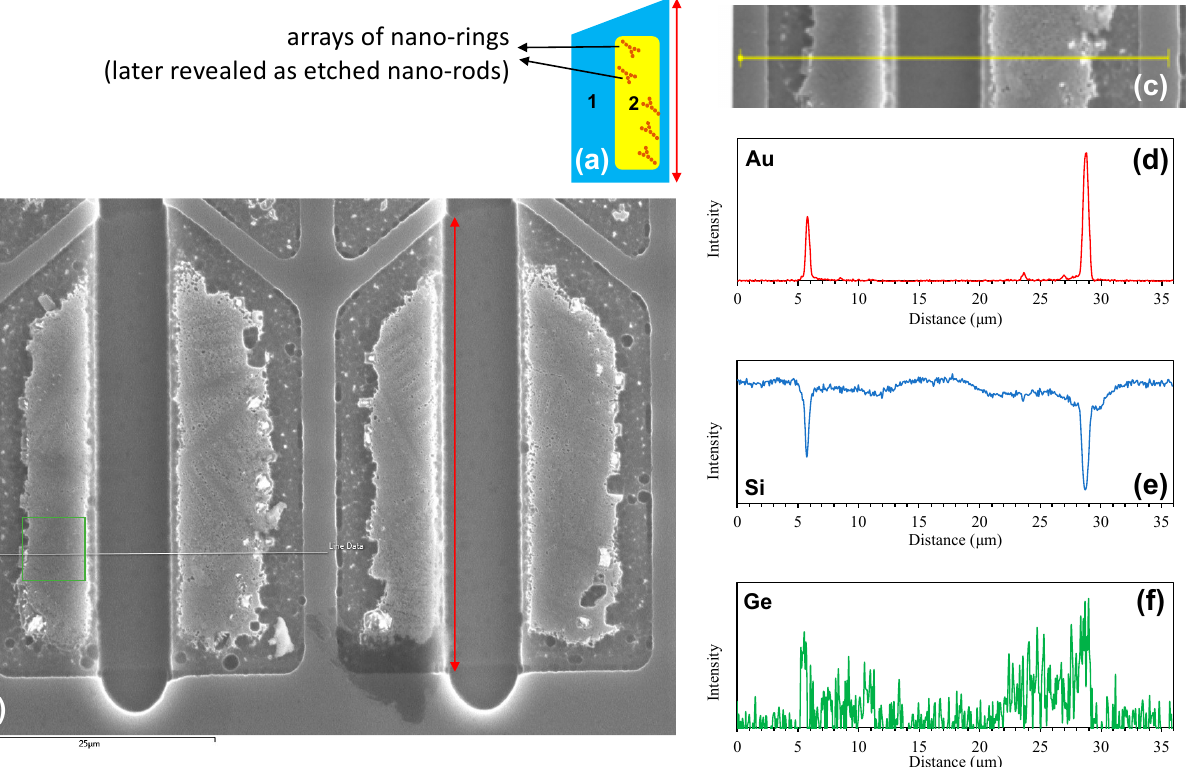
Figure 5. ( a ) Plan-view schematic of the sample with a large opening (shown by a red double arrow) with two regions: (1) dark outer and (2) bright inner regions that have arrays of nano-rings (later revealed as etched nano-rods). ( b ) Plan-view SEM micrograph of micro-crucibles with a large opening showing the formation of arrays of nano-rings in region 2. The white line is an EDS line scan trajectory, cropped and realigned in ( c ). The corresponding EDS line scan spectra of Au, Si, and Ge species are shown in ( d ), ( e ), and ( f ), respectively.